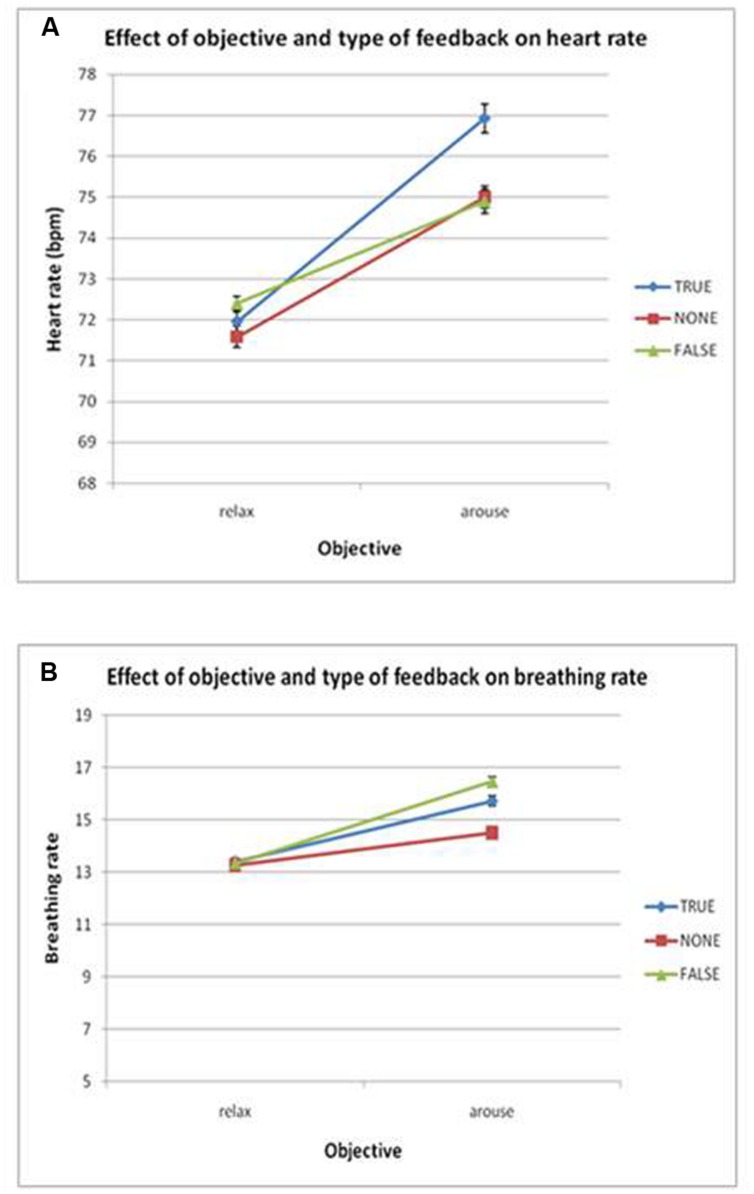
(A) Plots the group effects of objective and feedback on heart rate. There was a significant main effect of objective (p < 0.05) but no interaction of objective and feedback. (B) Breathing rate, no significant main effects or interactions were found. Error bars show SEM.